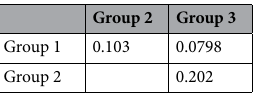
Table 2. Pairwise F st values among the three groups.